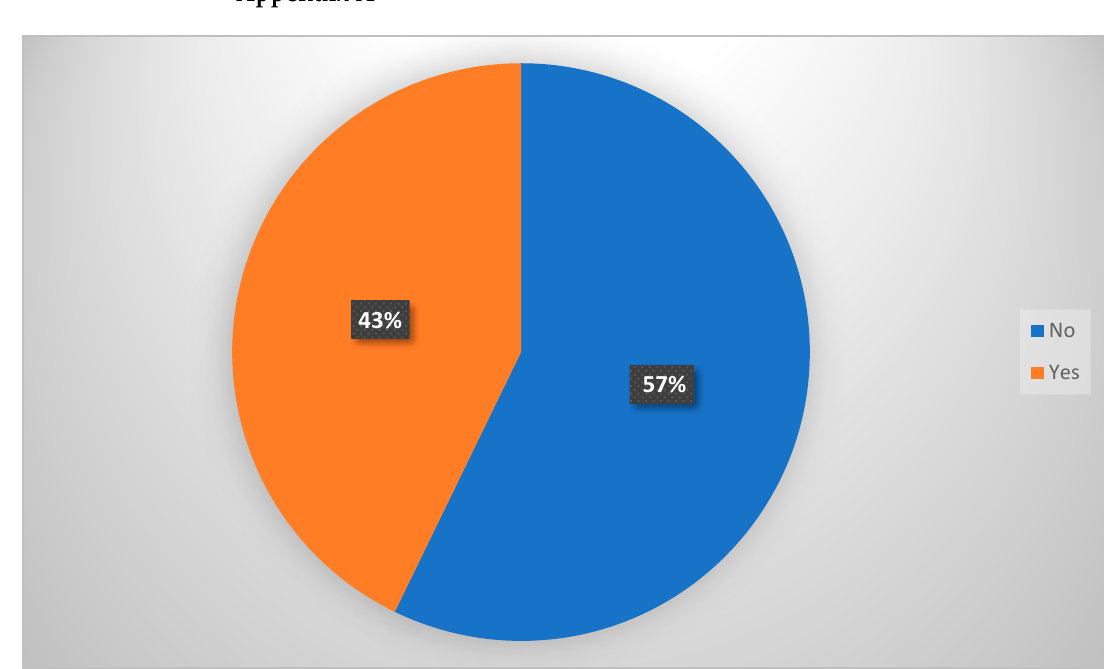
Figure A1. Parents’ willingness to give COVID-19 Booster vaccine to teenage (12–18 years) child.